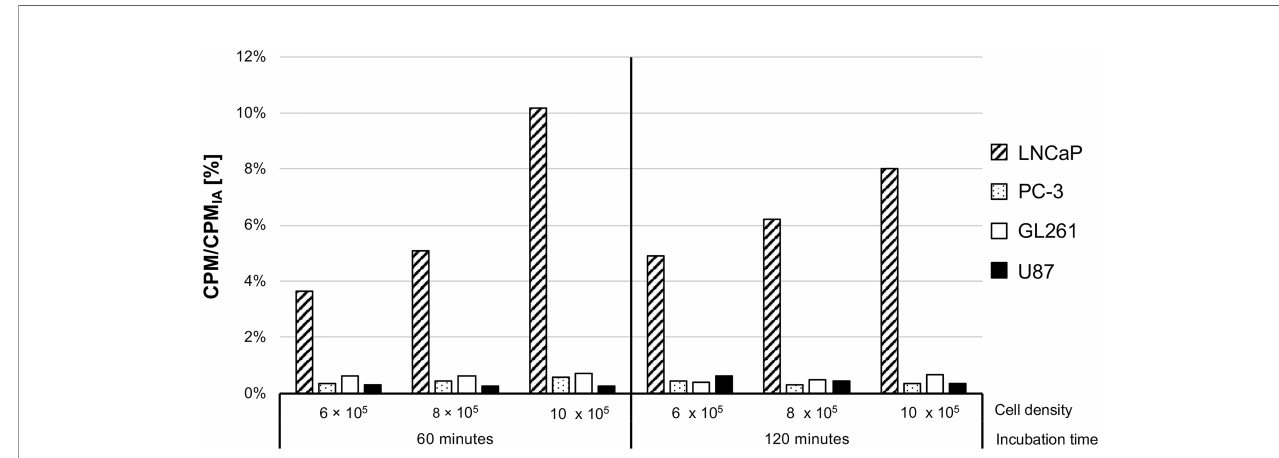
FIGURE 1 | In vitro 18 F-PSMA-1007 uptake. CPM/CPM IA : Internalization and binding given as a fraction of initially added activity. LNCaP and PC-3 cells served as PSMA positive and negative controls,